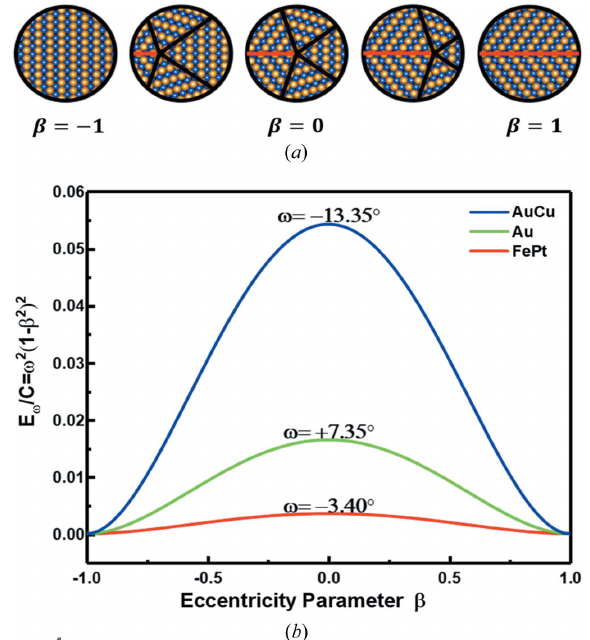
Figure 4 Eccentricity and energy barrier of disclination. ( a ) Diagram of small particles with different eccentricity which can be evaluated by parameter (cid:4) ranges from (cid:2) 1 to 1. ( b ) Curves of the disclination energy barrier with different eccentricity of different